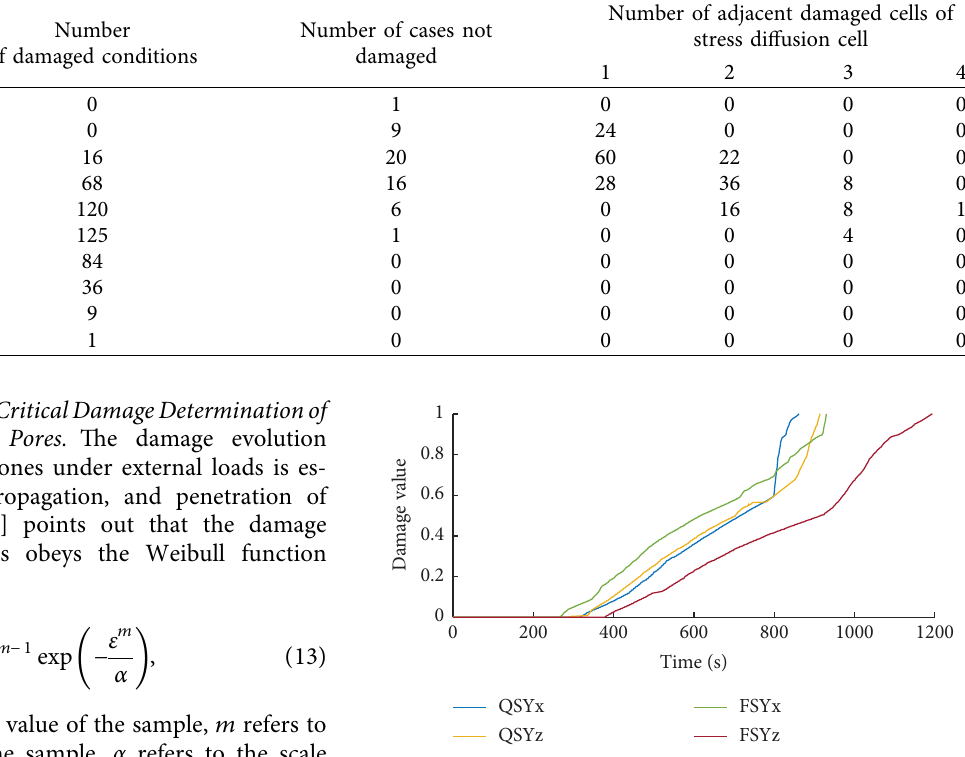
Figure 13: Damage evolution process of sandstone with different